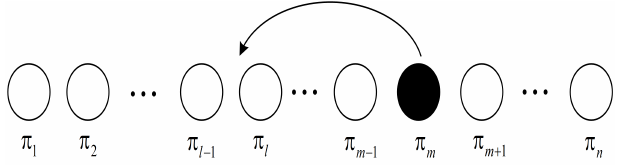
Figure 5. Illustration of Insertion